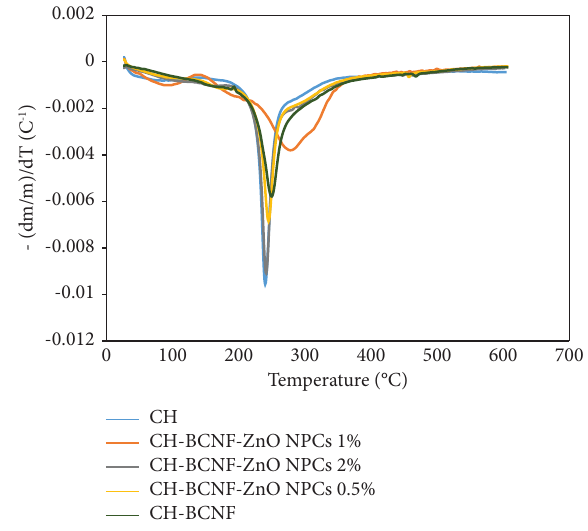
Figure 3: DTG thermograms of diferent